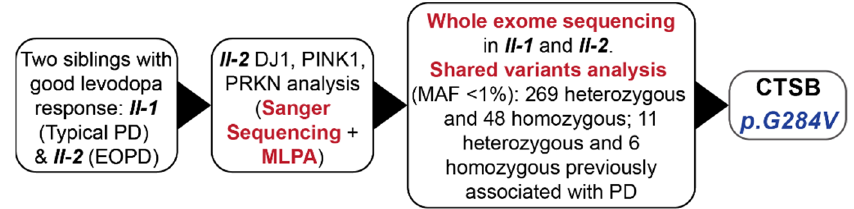
Figure 2. Flowchart of genetic experiments conducted on the typical PD family. EOPD = early onset Parkinson’s disease, MAF = minor allele frequency, MLPA—Multiplex ligation-dependent probe amplification. Table 1. Summary of shared variants in affected siblings previously associated with PD.